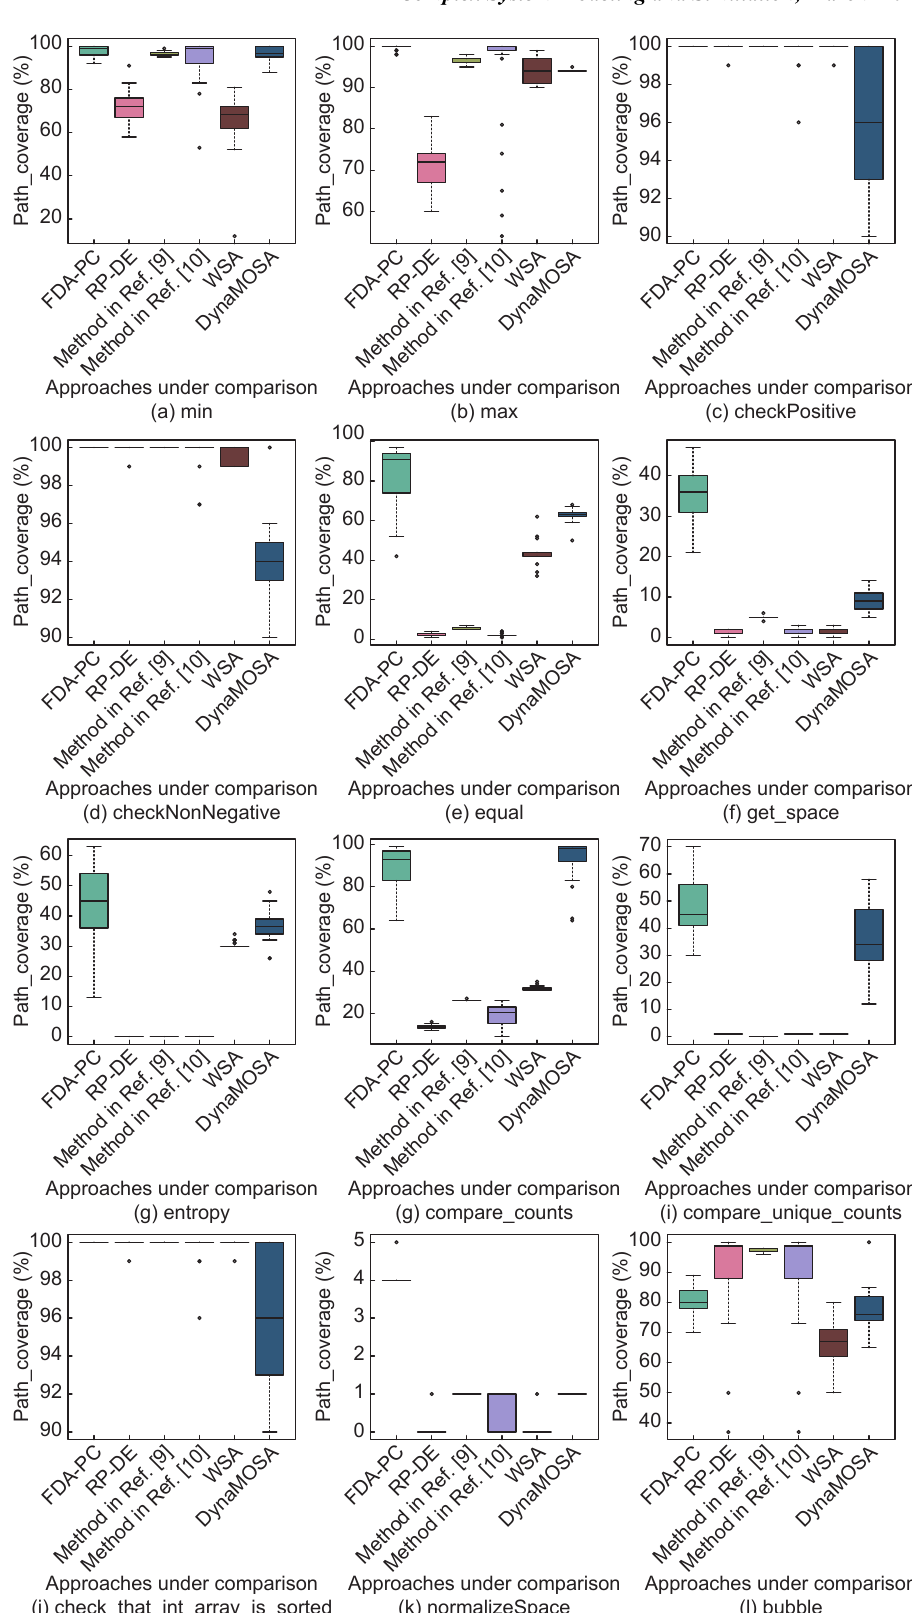
Fig. 4 Box plots for min, max, checkPositive, checkNonNegative, equal, get_space, entropy, compare_counts, compare_unique_counts, check_that_int_array_is_sorted, normalizeSpace, and